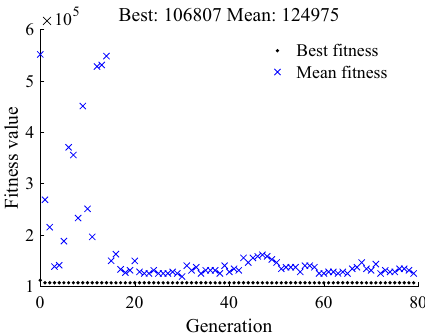
Figure 6. Fitness value of genetic algorithm.